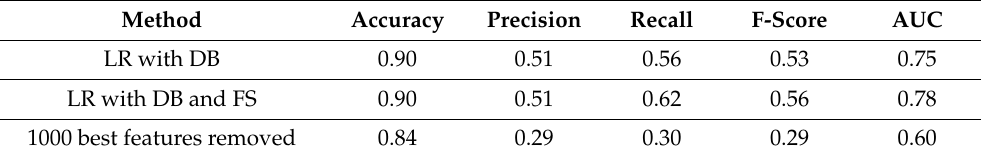
Table 6. Results of removing 1000 most important features.